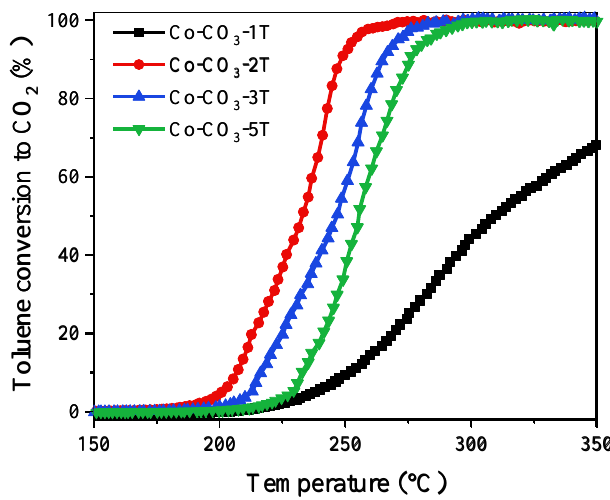
Figure 10. Light-o ff curves of the catalysts in the oxidation of toluene. Figure 10. Light-off curves of the catalysts in the oxidation of toluene. Table 3. Catalytic performance and kinetic analysis of the catalysts for toluene